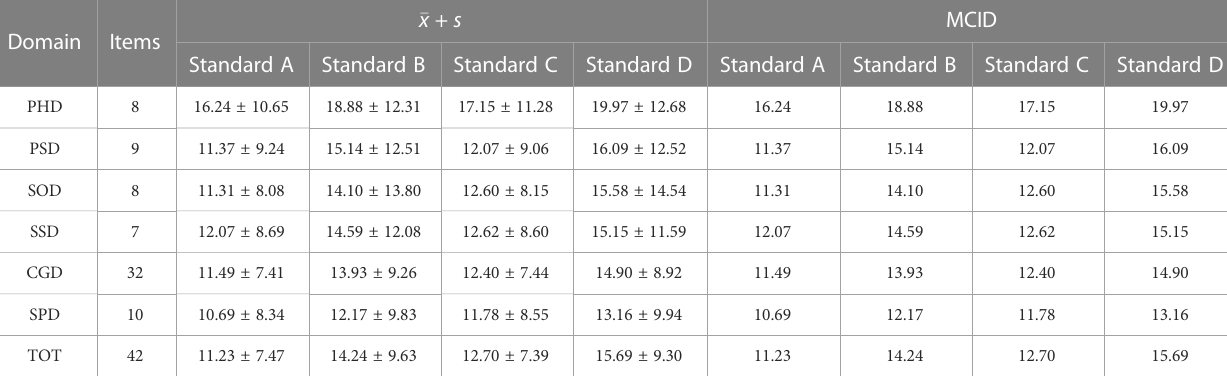
TABLE 2 The MCID of QLICP-BR (V2.0) determined by traditional anchor-based methods under different standards ( n A =116, n B =166, n C =90, n D =136).